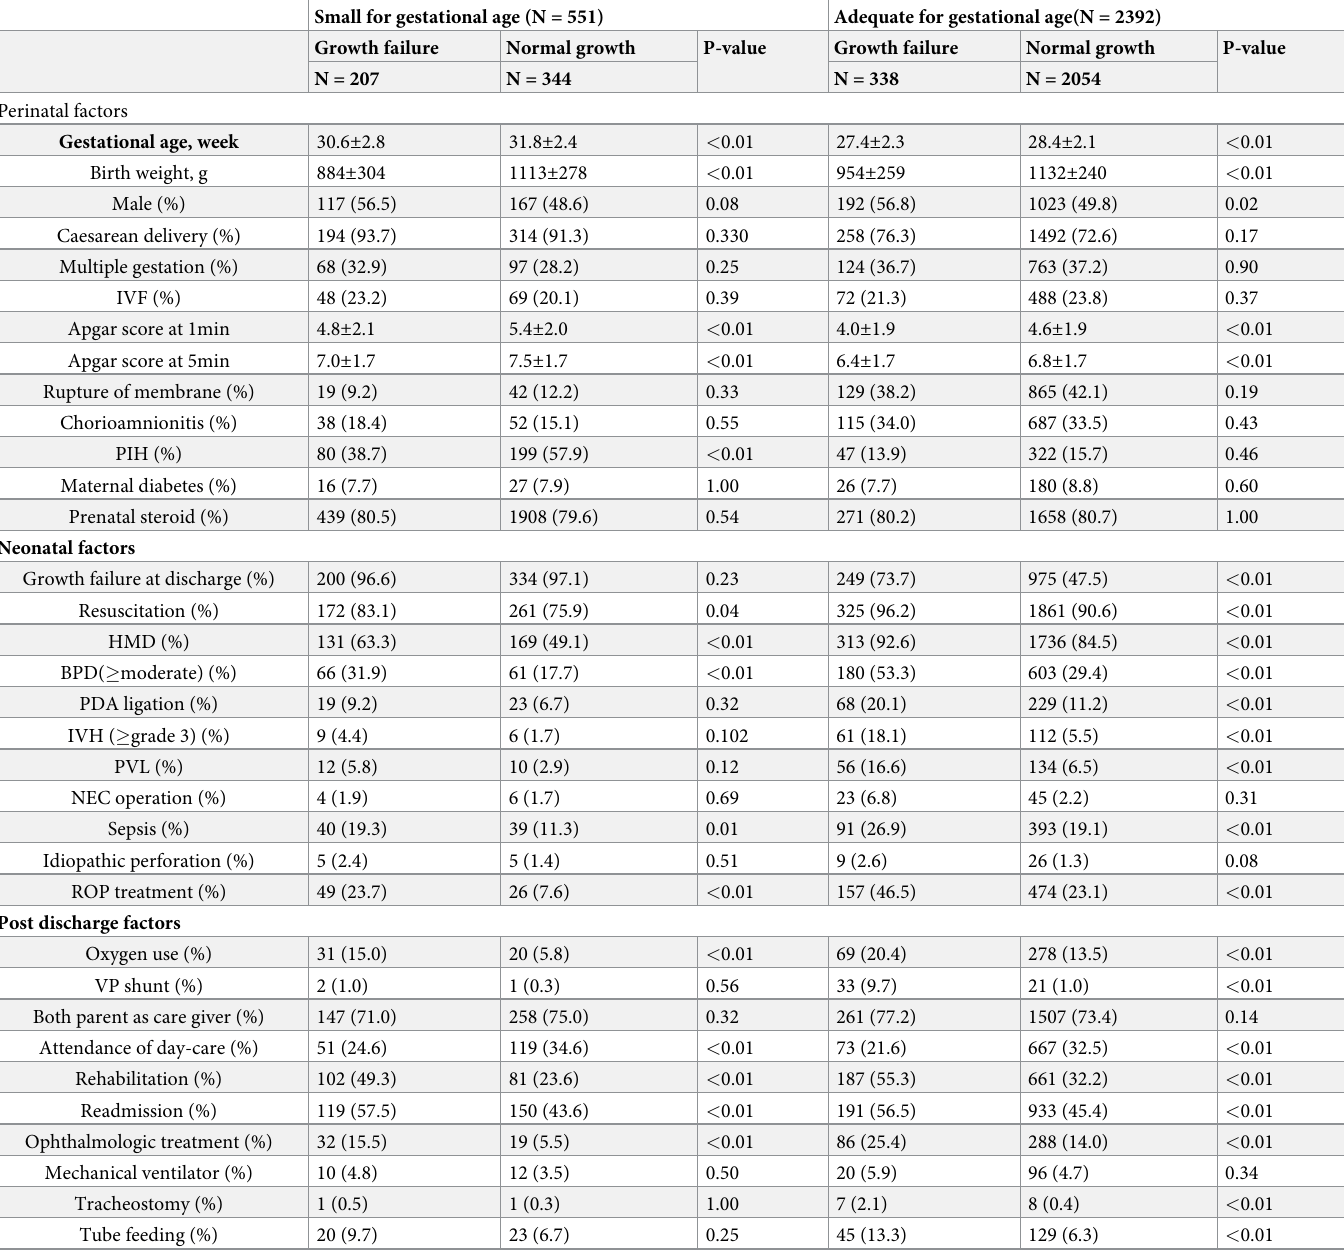
Table 2. Comparison of various factors between growth failure and normal growth groups at follow-up 1 in SGA infants and AGA infants by univariate analysis. Small for gestational age (N =